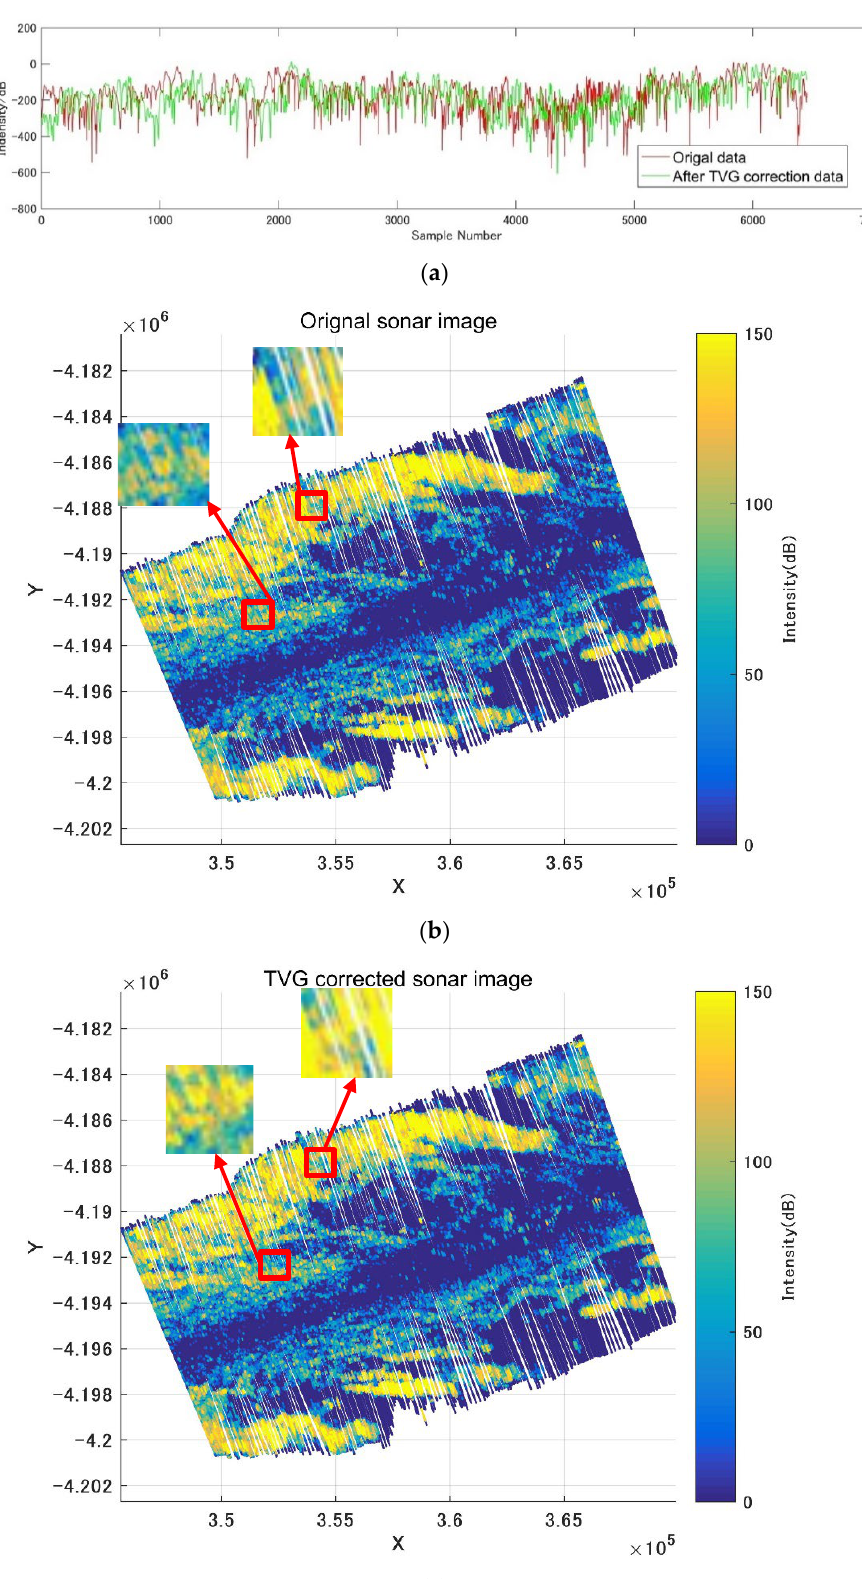
Figure 5. Influence of propagation loss on backscatter intensity: ( a ) correction intensity diagram of acoustic signal propagation loss; ( b ) original sonar image without TVG correction; and ( c ) seabed sonar image after TVG